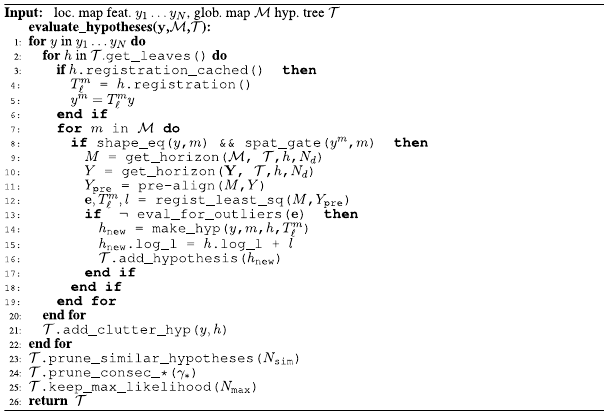
Algorithm 2. The algorithm used to evaluate the hypotheses once a new set of local map features is available. It assumes that the tree already contains one or more levels. If the tree is empty, only feature shape is considered for the fi rst local map feature.